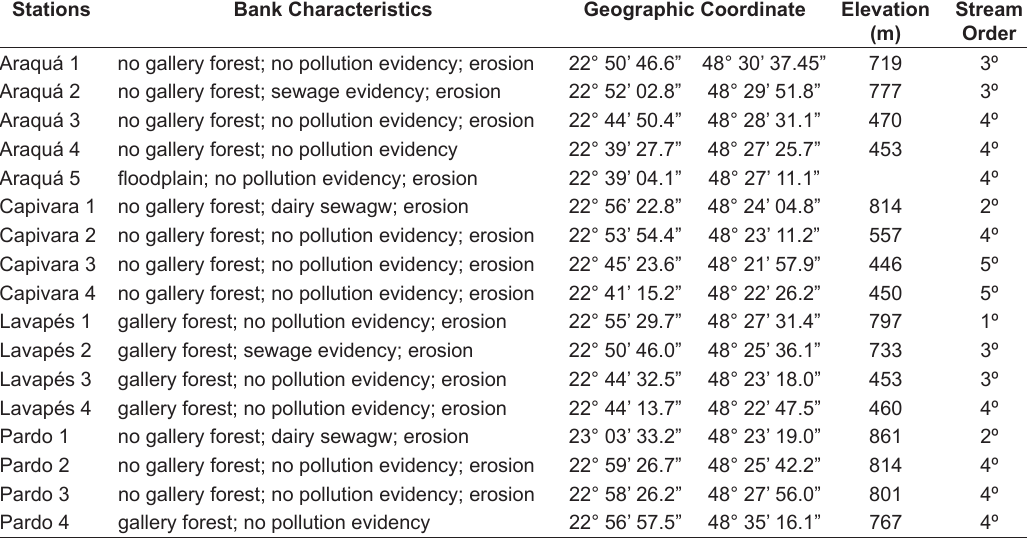
Figure 1. Study area and sampling stations locations. In gray, the urban area of Botucatu, São Paulo, State. Table 1. List of the sampling stations, geographic positioning and some general environmental